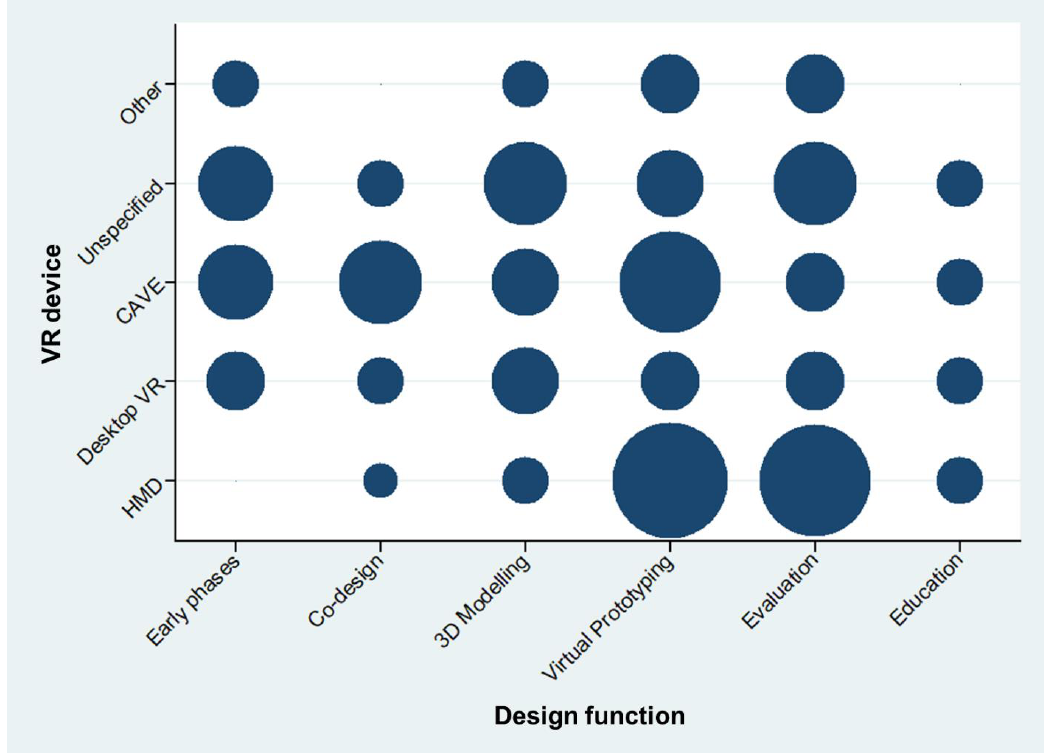
Figure 6. Distribution of the number of applications of specific VR technologies supporting specific design functions.